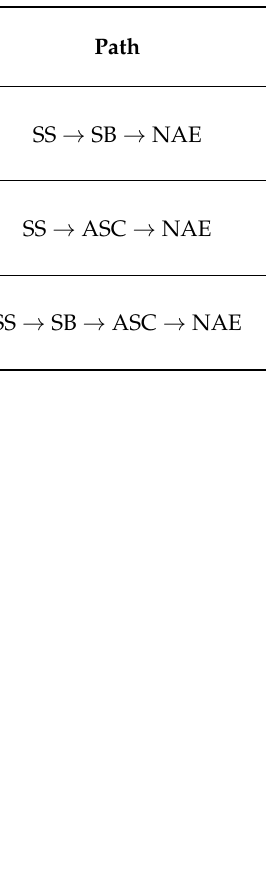
Figure 5. A diagram of the moderated serial mediation model, with negative achievement emotions as the dependent variable. SS—school status; SB—sense of school belonging; ASC—academic self-concepts; PAE—positive achievement emotions; IR—individual ranking; * p < 0.05; ** p < 0.01. Table 6. Moderated serial mediation results, with negative achievement emotions as the dependent variable. SS—school status; SB—sense of school belonging; ASC—academic self-concepts; NAE— negative achievement emotions.